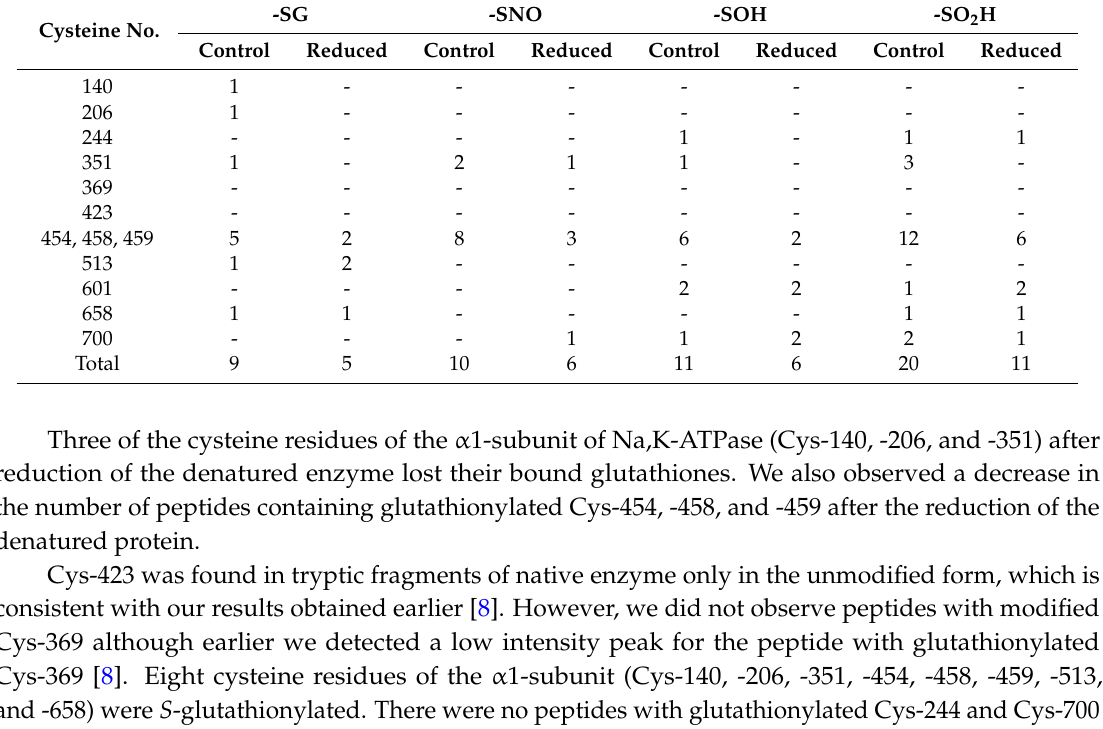
Table 1. Number of peptides (including sequences with different number of trypsin miscleavage sites) with redox-modified cysteine residues (-SG, glutathionylated Cys; -SNO, nitrosylated Cys; -SOH and -SO 2 H, oxidized Cys) revealed by matrix assisted laser desorption ionization-time of flight mass spectrometry (MALDI-TOF-MS) analysis under control conditions (Control) and after treatment with sodium borohydride (Reduced) under denaturing conditions. Cysteine